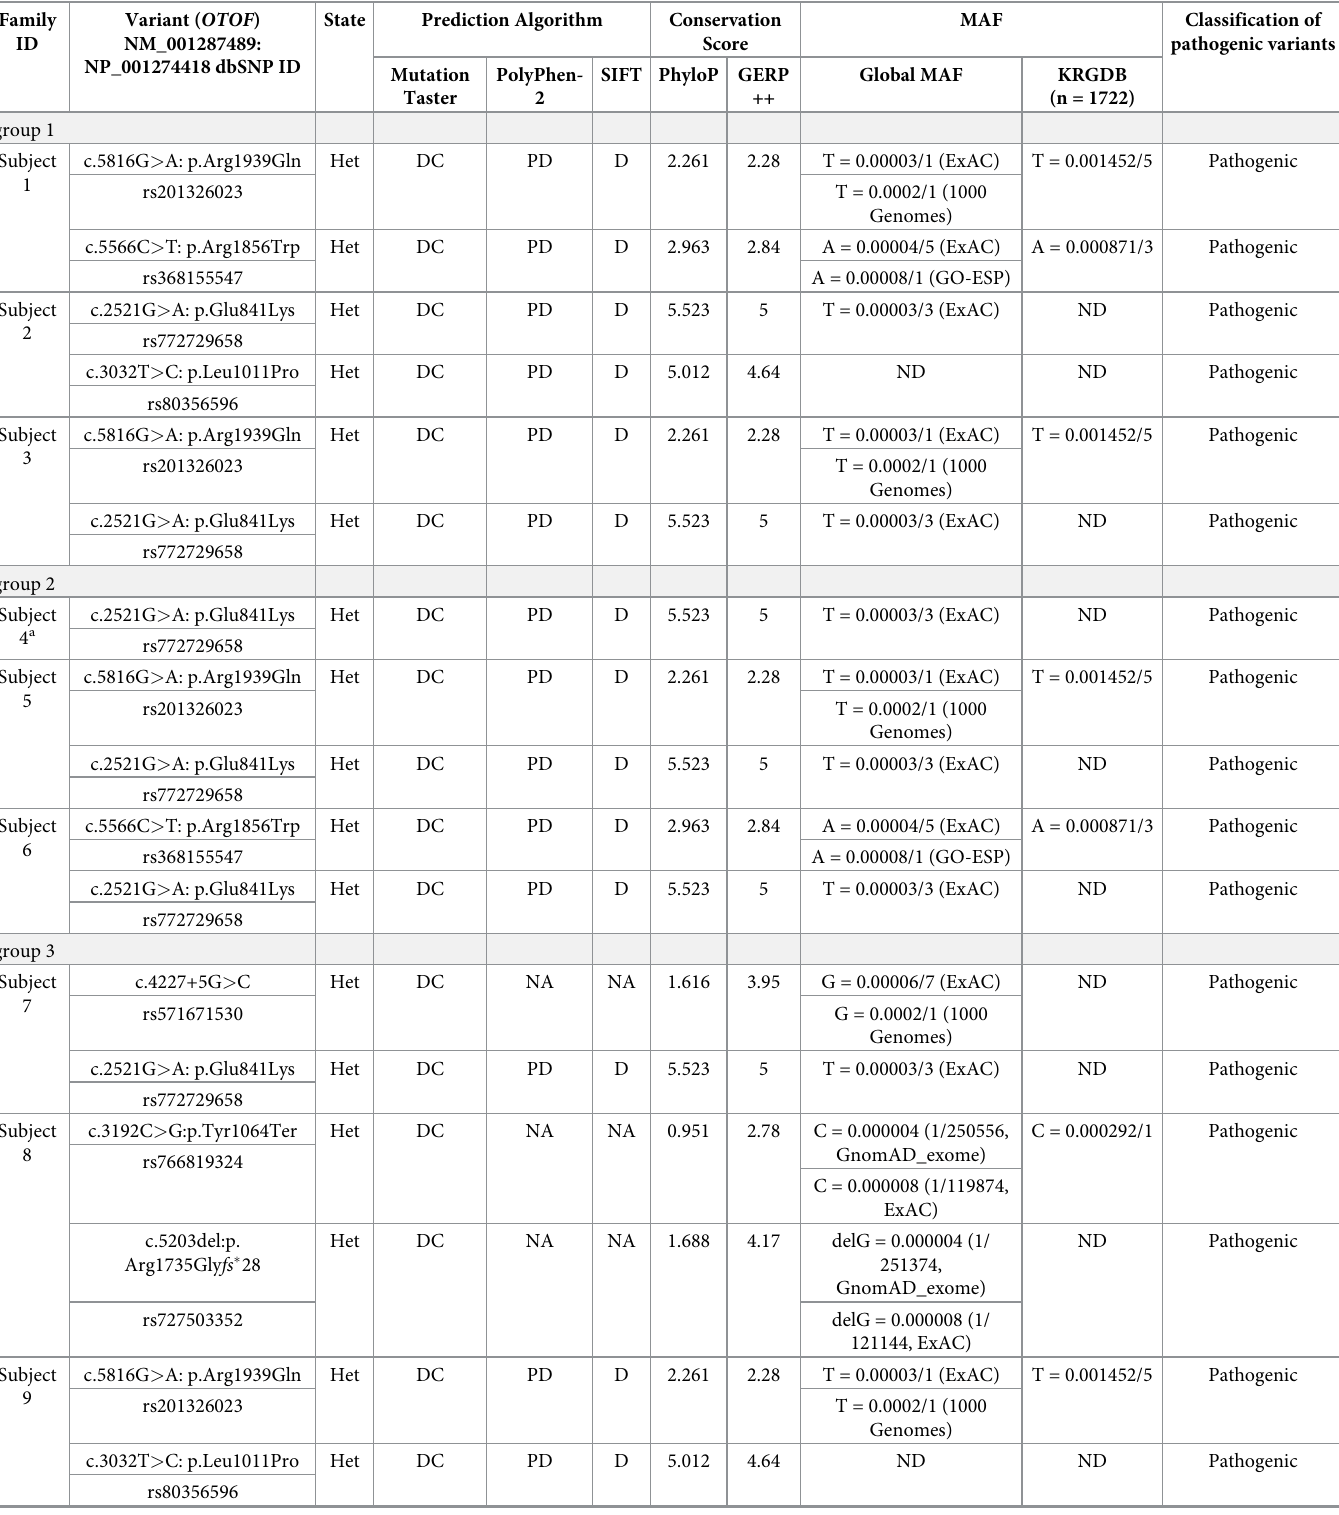
Table 2. Mutational spectrum of subjects with DFNB9 in our cohort. Family